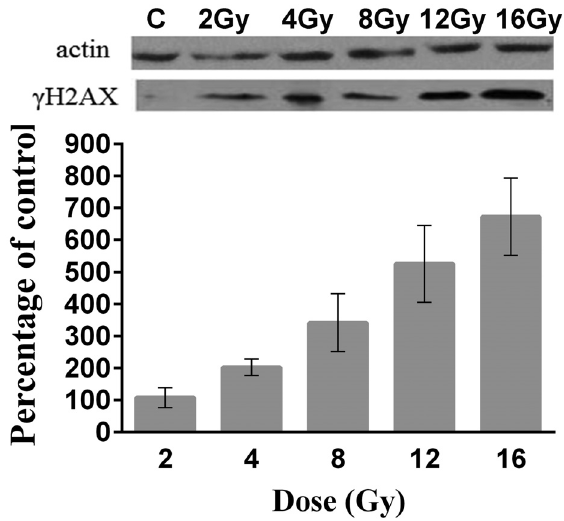
Figure 4 - Dose dependent phosphorylation of H2AX protein in HTB140 cells, given as percentage of control and analyzed by Western blot, 30 min after irradiation with γ -rays (C-control) . Data obtained from 3 experiments are presented as mean ±